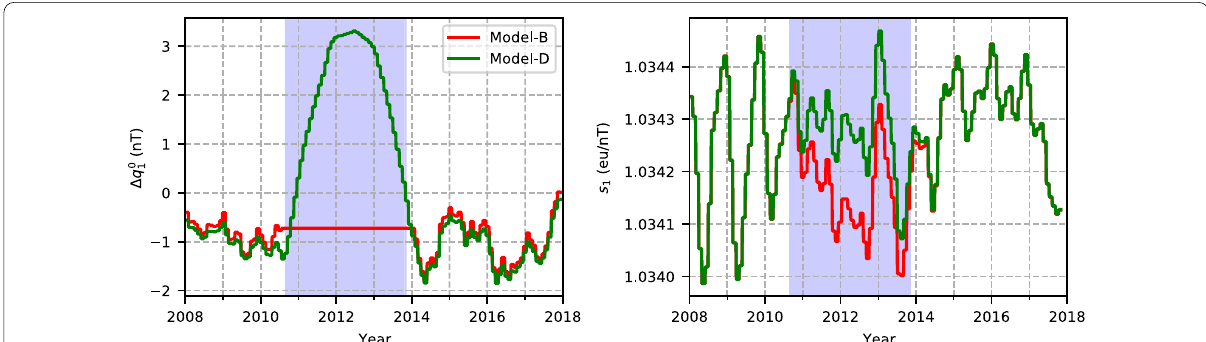
Fig. 7 Time-series of the RC-baseline correction (cid:31) q 0 1 (left) and sensitivity s 1 for GRACE-A as computed from Model-B and Model-D (right). The gap period between CHAMP and Swarm is indicated as a blue-shaded region (Sep 2010 to Nov 2013). For Model-D, the bins of the RC-baseline corrections are 30 days over the entire model time span, while they were merged to a single bin in the gap period for